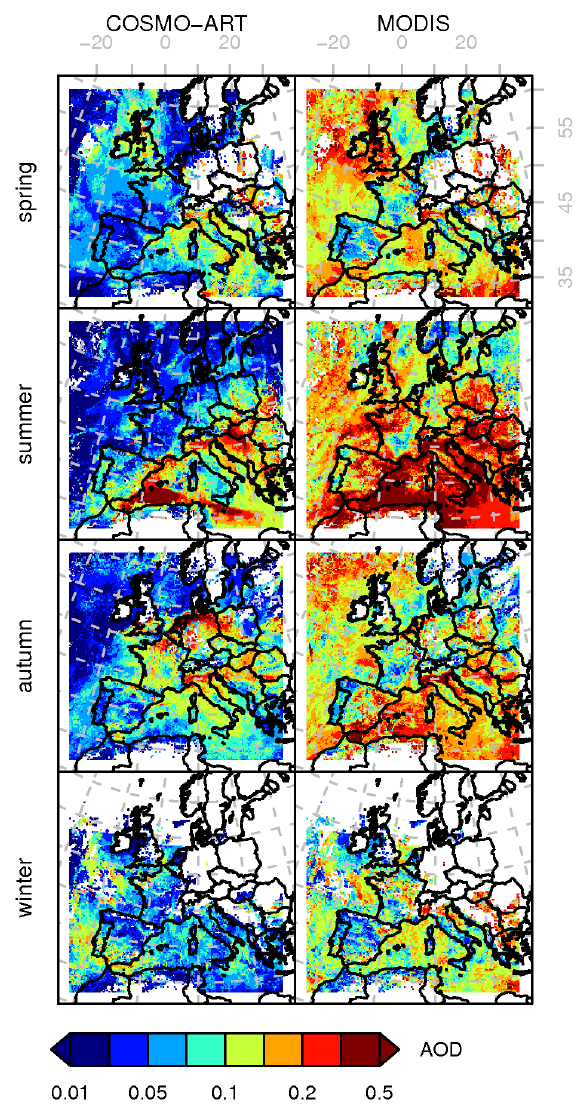
Fig. 7. Comparison of modelled AOD (550 nm) against MODIS satellite data for (from top) the spring 2009, summer 2006, autumn 2008 and winter 2006 periods. Modelled values are found on the left, MODIS observations on the right hand side.